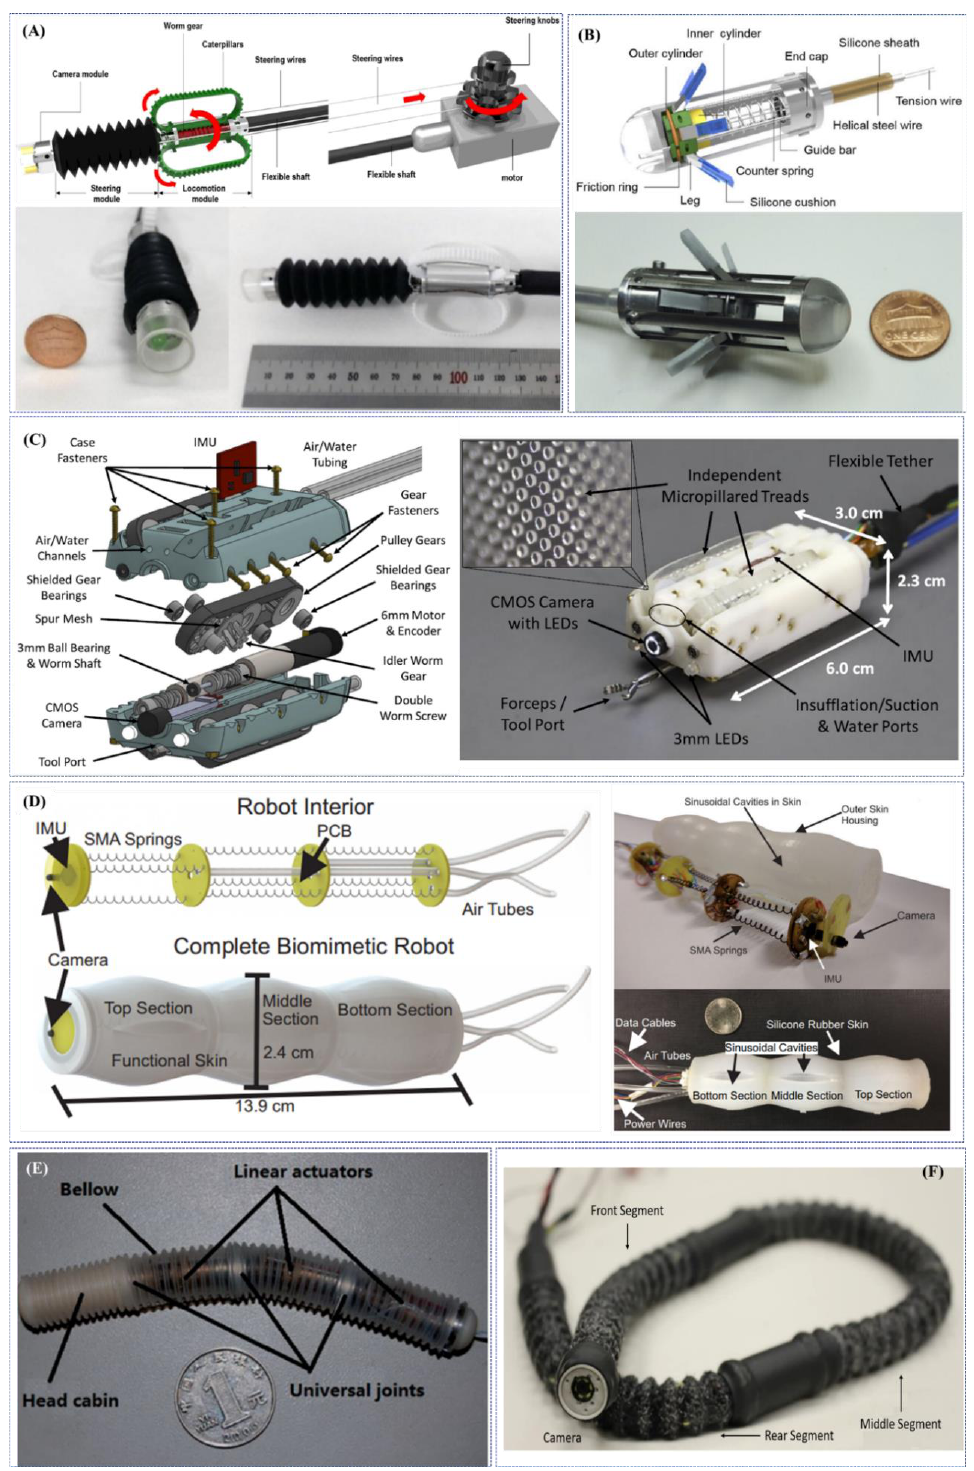
Figure 4. Examples of research-oriented innovative robotic colonoscopes and devices with electric actuation: ( A ) flexible caterpillar-based robotic colonoscope developed by Kim et al. [91] and Lee et al. [92]; ( B ) reel mechanism-based tethered colonoscope developed by Lee et al. [94]; ( C ) multi-DOFs sensor-enabled treaded robotic colonoscopes developed by Formosa et al. [97]; ( D ) SMA-actuated biomimetic robot developed by Ortega et al. [98]; ( E ) electrically-actuated worm-like robotic endoscope developed by Wang et al. [99]; ( F ) worm-like endoscopic robot developed by Bernth et al. (Courtesy of Prof. Hongbin